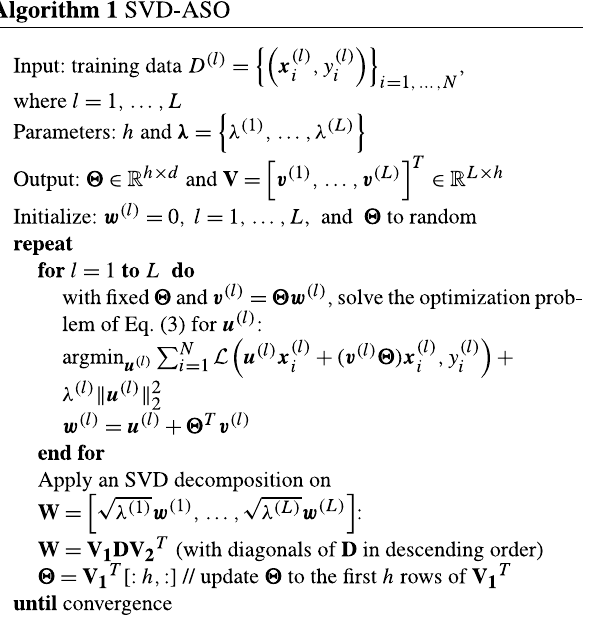
d of the high-dimensional space and the weight vector v (l) R ∈ d h is common for all the tasks. R × ∈